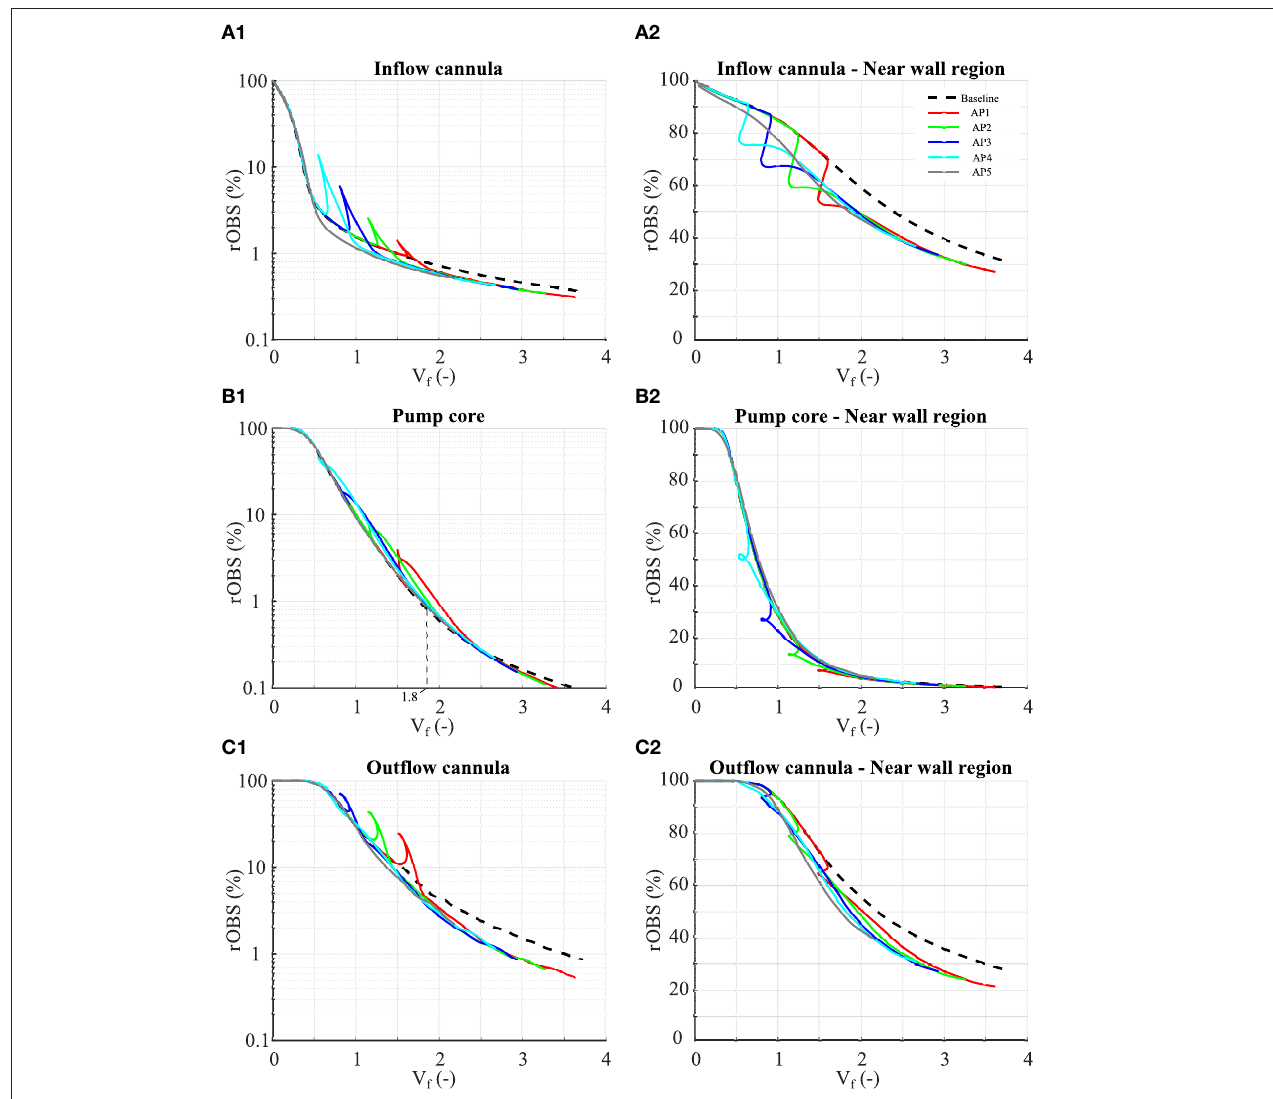
FIGURE 5 | Residual OBS concentrations in the inflow cannula (A1–A2) , pump core (B1–B2) , and outflow cannula (C1–C2) . Definition of the different parts is given in Figure 1. (A1–C1) Residual OBS concentrations for the each pump part. Note that the results are plotted using a logarithmic scale for the residual